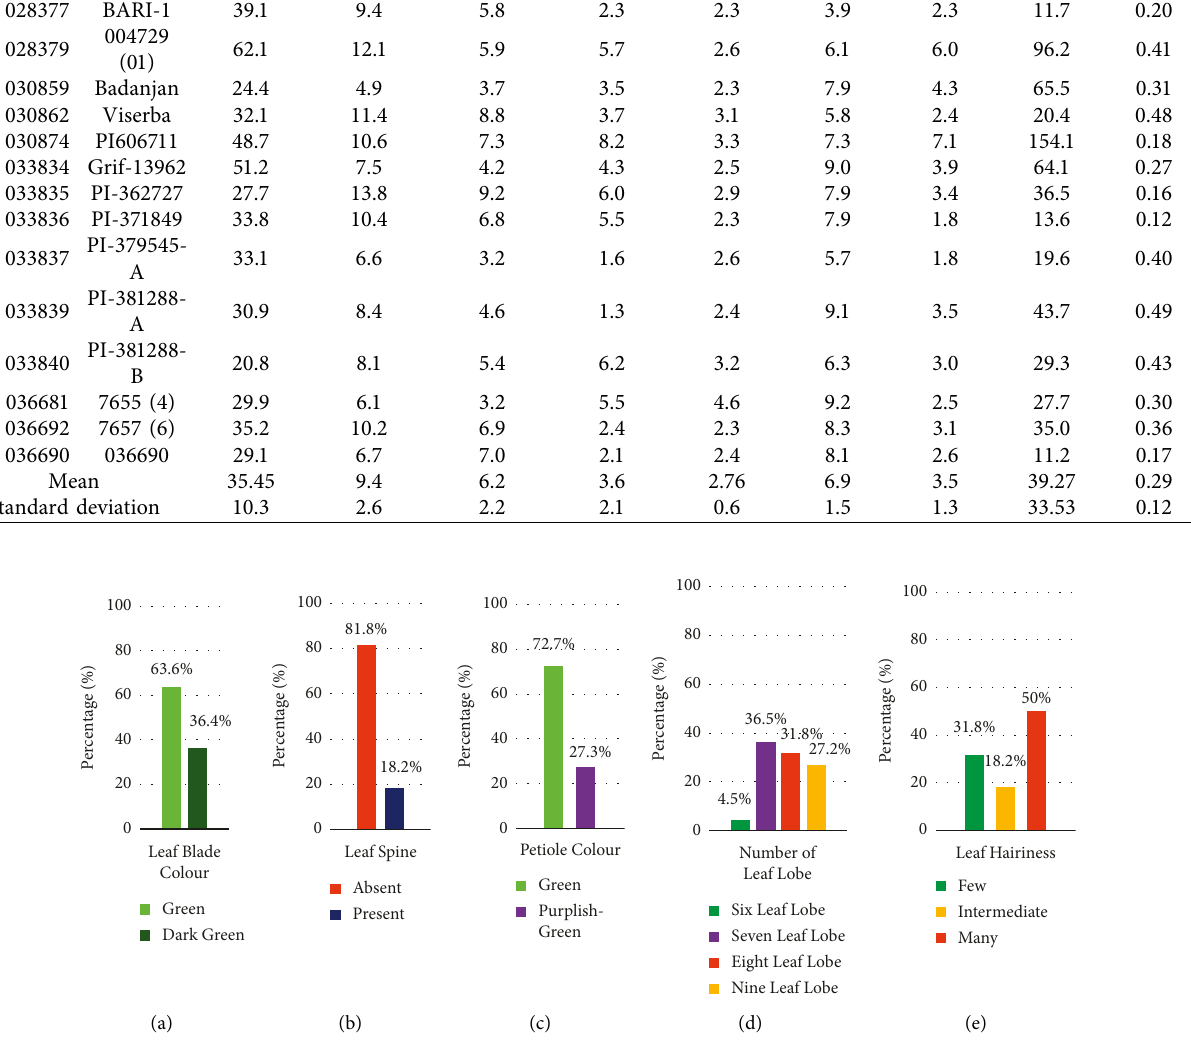
Figure 1: The percentage range of variation in morphological leaf parameters. (a) Leaf blade color. (b) Leaf spine. (c) Petiole color. (d) Number of leaf lobe. (e) Leaf